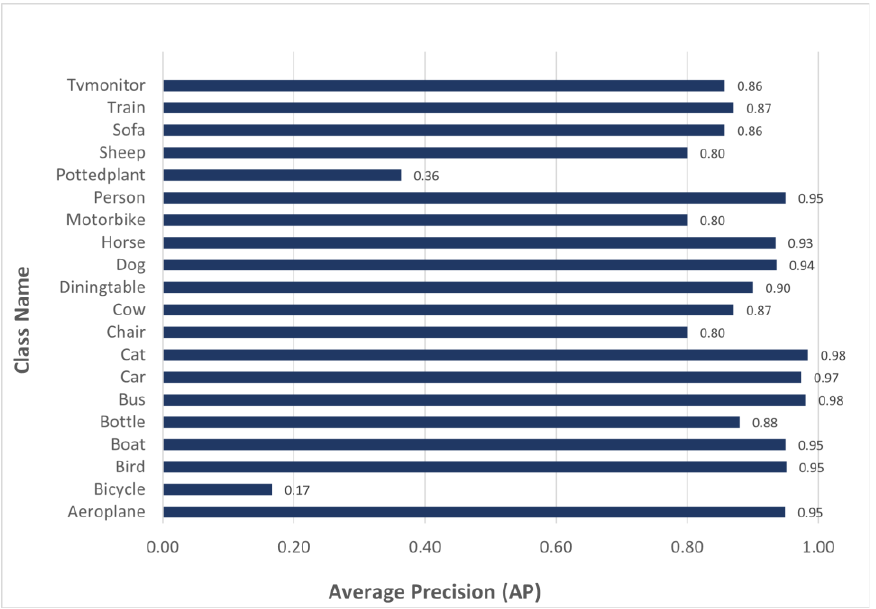
Figure 8. Average precision (AP) per class.